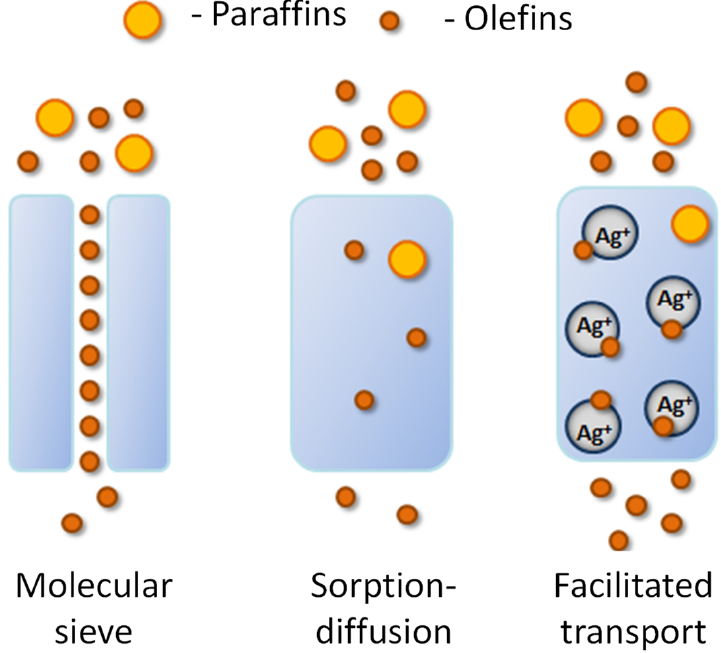
Figure 1. Schematic representation of the various transport mechanisms.